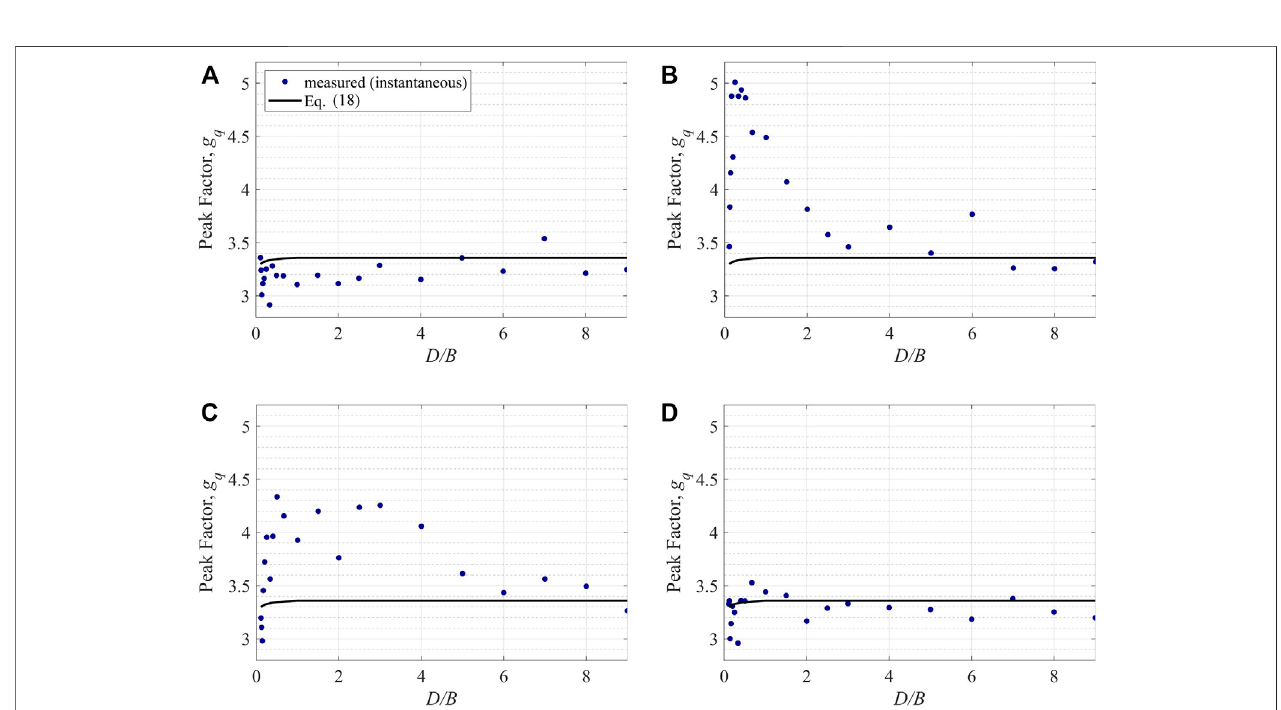
FIGURE 10 | Measured and predicted peak response factors, g q , for area-averaged pressure coef fi cients on the (A) windward wall, (B) side wall, (C) leeward wall and for (D) drag coef fi cients under the orthogonal wind direction.